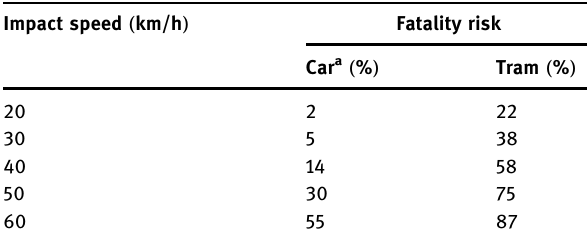
Table 2: Comparison of the pedestrian fatality risk when being hit by a car and